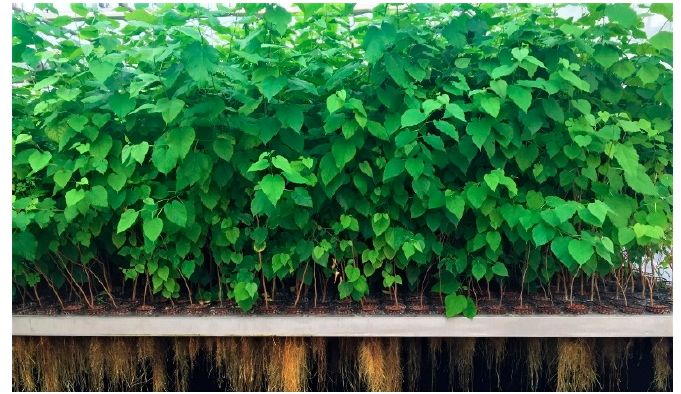
Figure 1. Morus alba L. trees cultivated in aeroponic conditions.